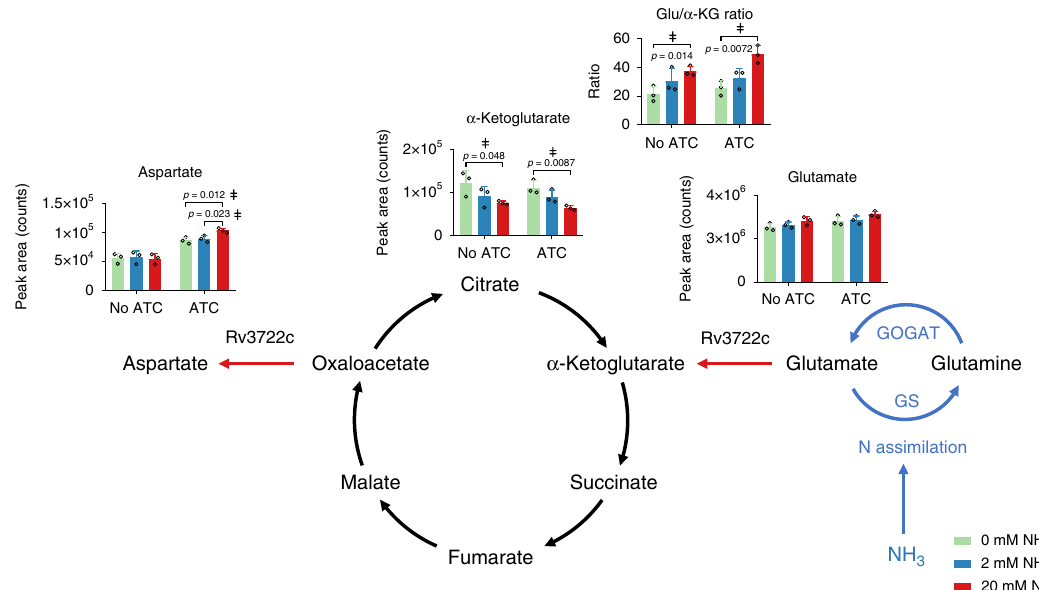
Fig. 6 Rv3722c links nitrogen assimilation to aspartate synthesis. Rv3722c-TetON was cultured in modi fi ed minimal TSM media supplemented with 2 mM ammonium chloride and 1% casein hydrolysate, with or without ATC, to predeplete Rv3722c. After adaptation (24 h) to the same media without casein hydrolysate and 2 mM ammonium chloride as sole nitrogen source, the media was replaced with the same media containing 0 (green), 2 (blue), or 20 mM (red) ammonium chloride. After 4 h at 37 °C, the relative levels of the indicated metabolites were determined using LC-MS. Blue arrows indicate reactions involved in nitrogen assimilation (GS glutamine synthetase, GOGAT glutamine oxoglutarate aminotransferase), while red arrows indicate the direction of the Rv3722c-mediated reaction. Data are presented as individual datapoints (open circles) and mean + / − SD of three experimental replicates ( n = 3), representative of two independent experiments. Statistically signi fi cant differences were identi fi ed by a combination of a two-sided unpaired Student's t test ( p < 0.05, as indicated) and Mann – Whitney U rank testing (for which the smallest possible p -value with n = 3 is 0.1) (double dagger); The Glu/ α KG ratio was calculated using Excel. Source data are provided as a Source Data fi